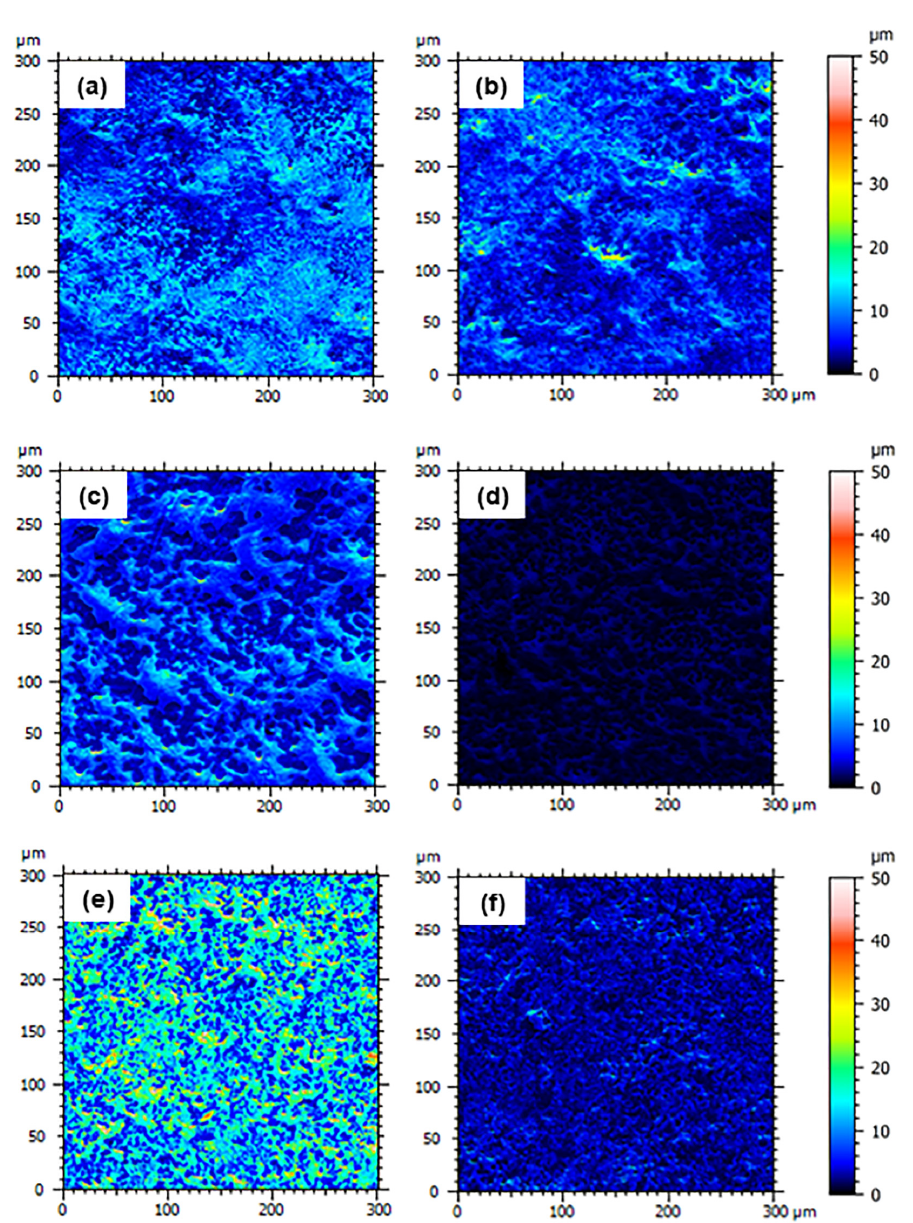
Figure 9. 3D surface reconstruction through SEM image processing of non-irradiated ( left ) and irradiated ( right ) samples of ( a , b ) MDPE/GNP 5 wt%, ( c , d ) MDPE/GNP 10 wt%, ( e , f ) MDPE/GNP 15 wt% nanocomposites.